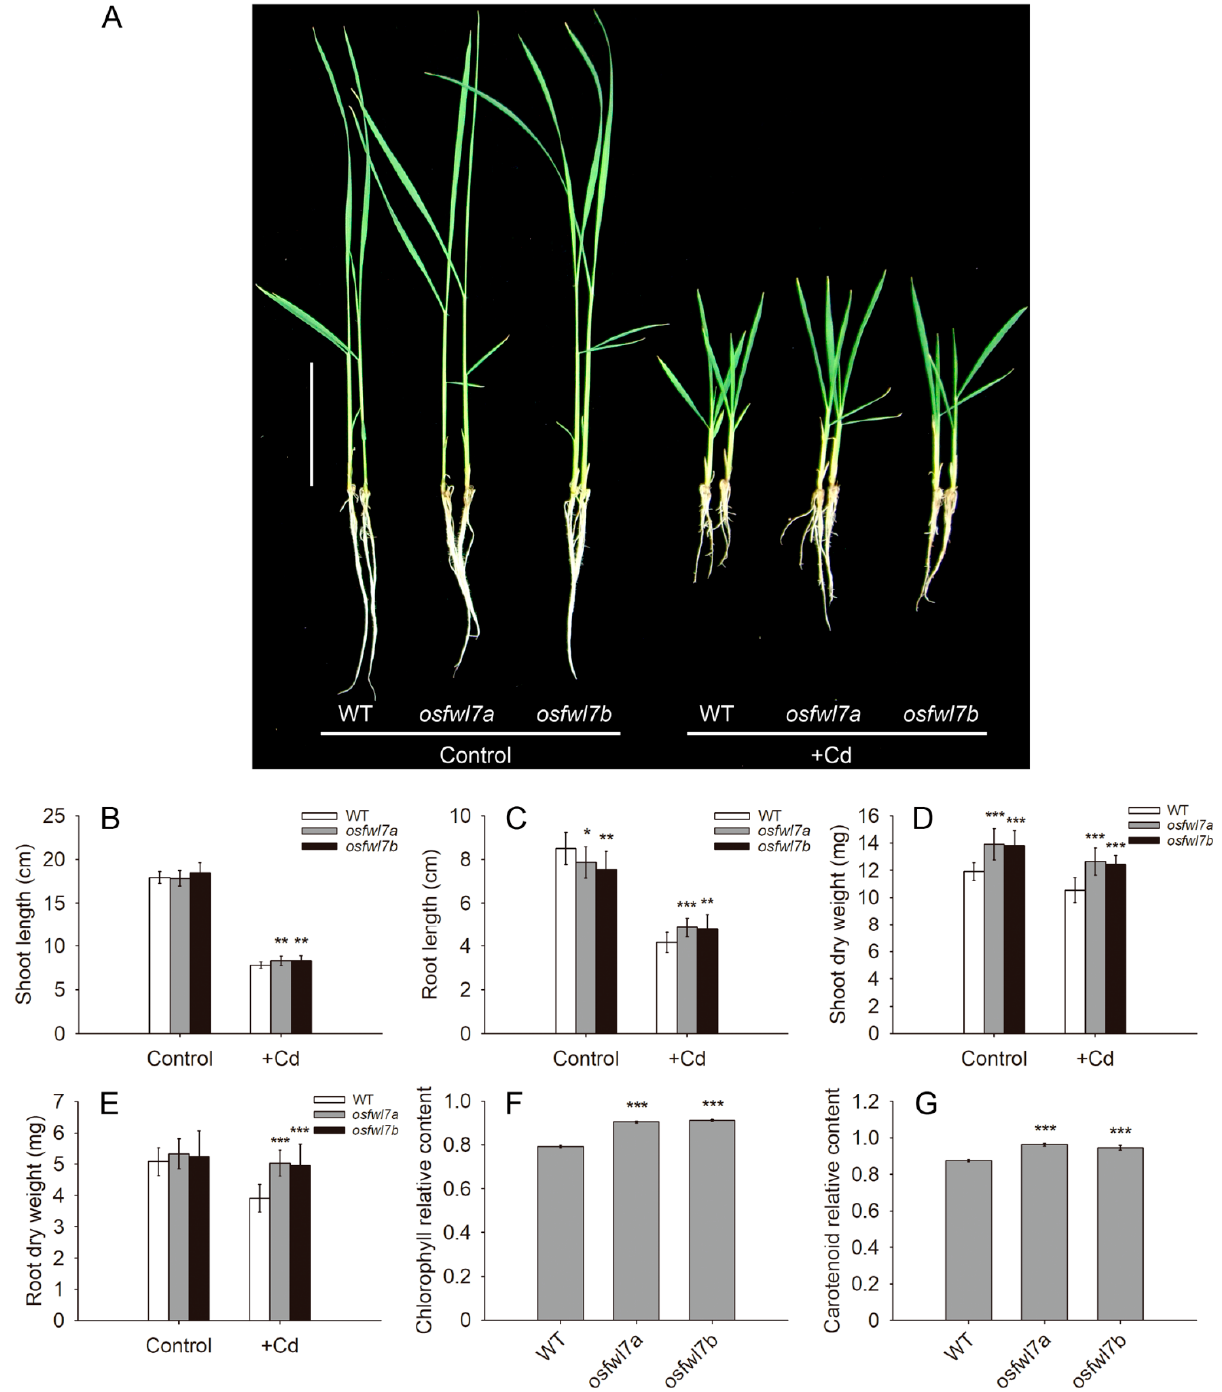
Figure 2. Performance of the wildtype (WT) and osfwl7 mutants under Cd stress. ( A ) WT and mutant plants grown under normal conditions and in the presence of 50 μ M Cd for 10 days, bar = 5 cm. ( B – E ) Shoot length ( B ), root length ( C ), shoot dry weight ( D ), and root dry weight ( E ) of the WT and mutants, n = 15. Error bars indicate standard deviation. ( F ) Relative chlorophyll content of the WT and mutants (chlorophyll content under Cd stress/chlorophyll content under normal con- dition). ( G ) Relative carotenoid content of the WT and mutants (carotenoid content under Cd stress/carotenoid content under normal condition). Error bars in ( F , G ) indicate the standard deviation of three biological replicates. * p < 0.05, ** p < 0.01, *** p < 0.001.